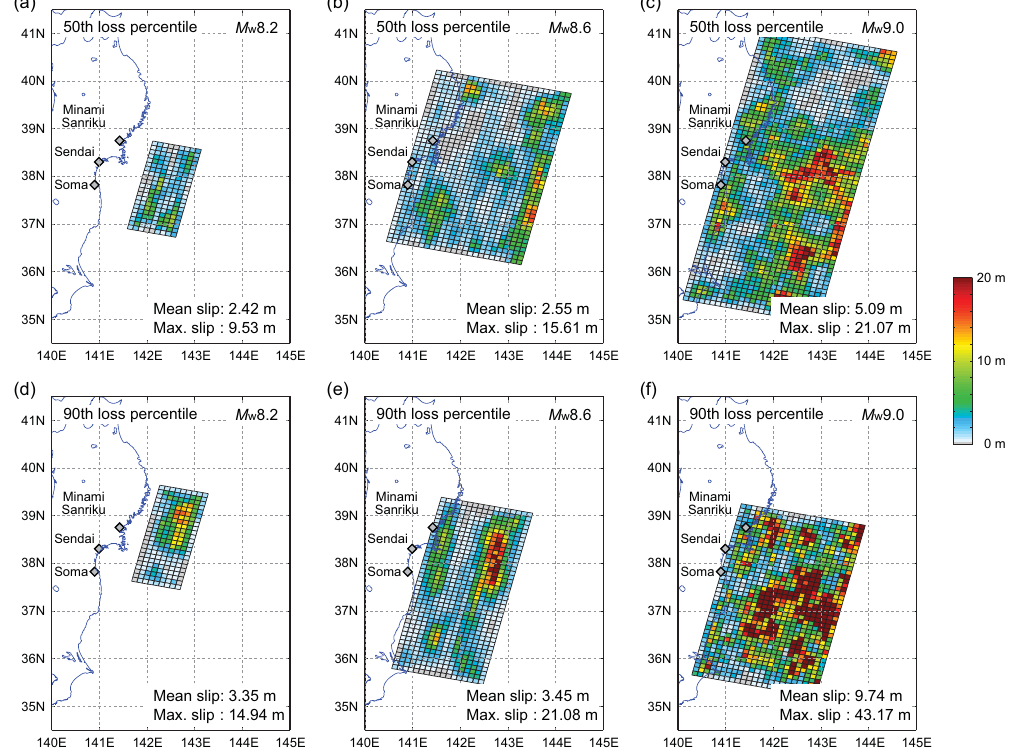
Figure 10. Earthquake source models corresponding to critical loss scenarios: (a) 50th loss percentile for M w 8.2, (b) 50th loss percentile for M w 8.6, (c) 50th loss percentile for M w 9.0, (d) 90th loss percentile for M w 8.2, (e) 90th loss percentile for M w 8.6, (f) 90th loss percentile for M w